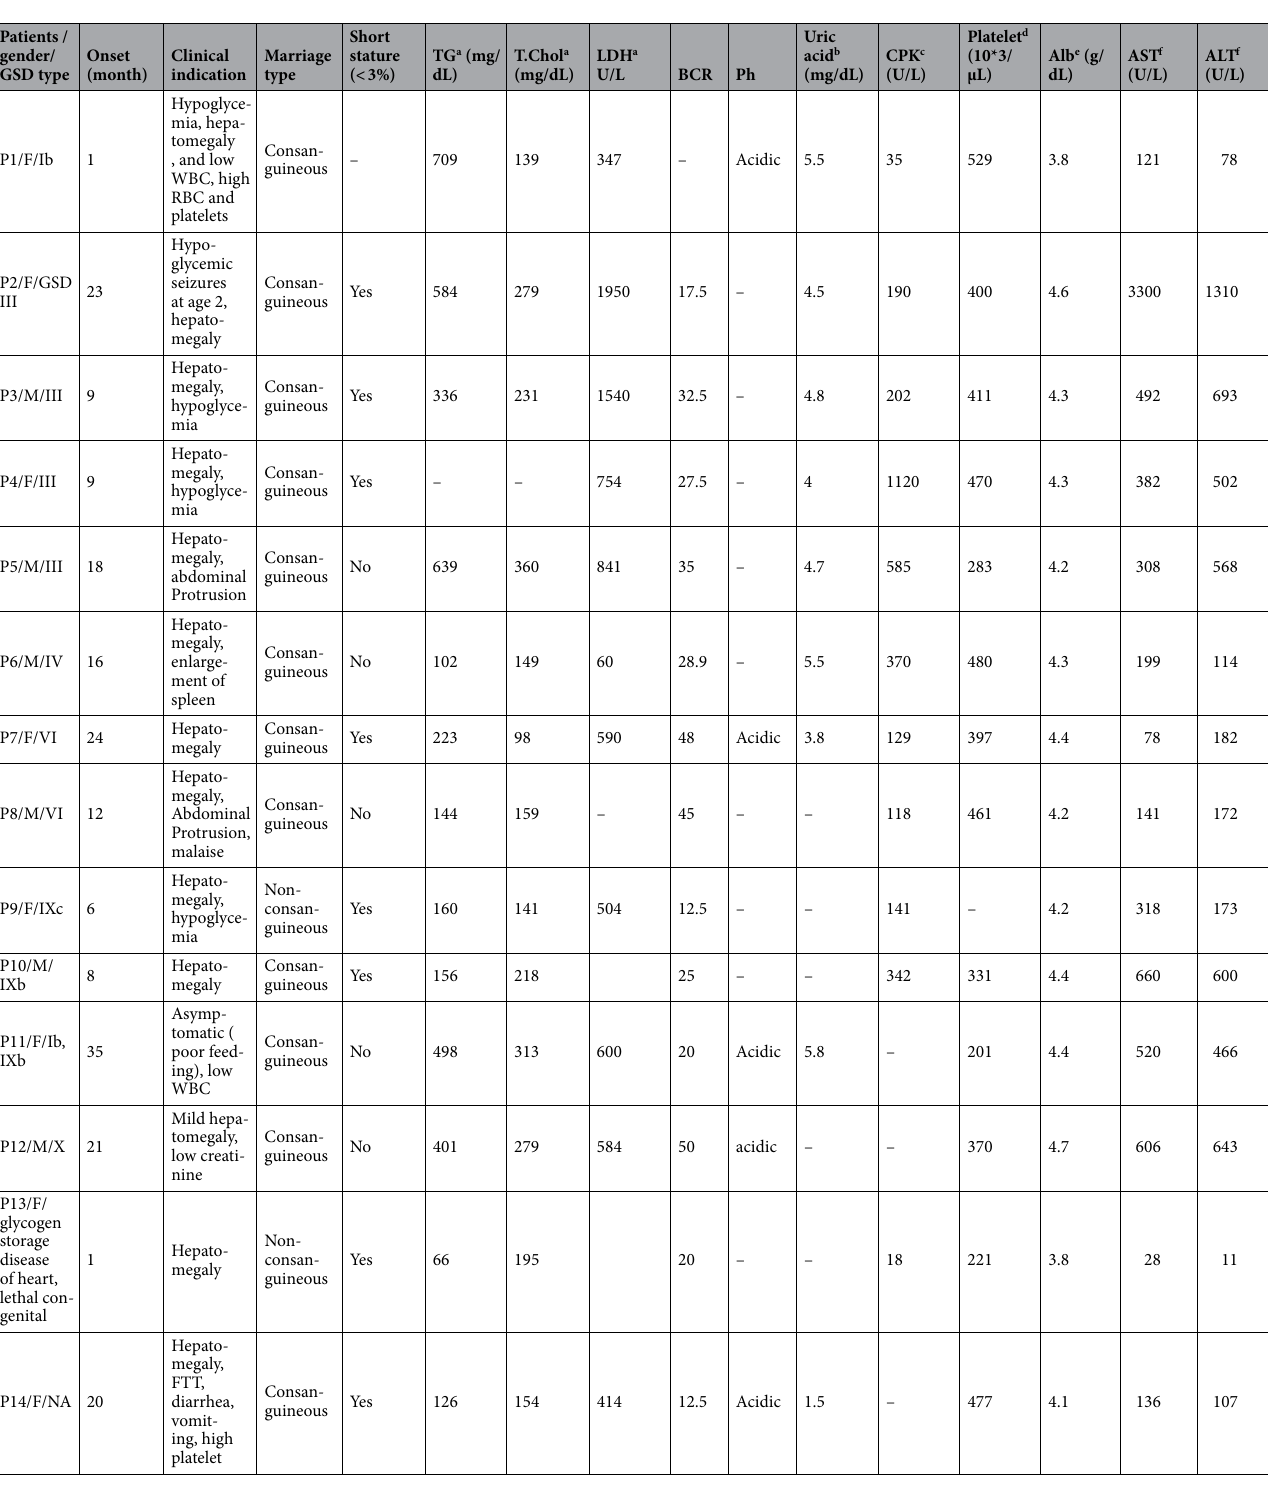
Table 1. Clinical manifestations of Iranian patients. GSD glycogen storage disease, FTT failure to thrive, TG triglyceride, Chol cholesterol, BCR blood urea nitrogen (BUN)/creatinine ratio, Alb albumin, ALT alanine transaminase, AST aspartate transaminase, CPK creatine phosphokinase. a Reference range for TG, Total chol < 150 mg/dL; LDH < 480 U/L. b Reference normal range for uric acid 3.5–8.2 mg/dL. c Reference normal range for CPK 24–195 U/L. d Reference normal range for Platelet 145–450 10*3/µL. e Reference normal range for Alb = 3.5–5.4 g/dL. f Reference range for liver enzymes: ALT < 40 U/L; AST < 45